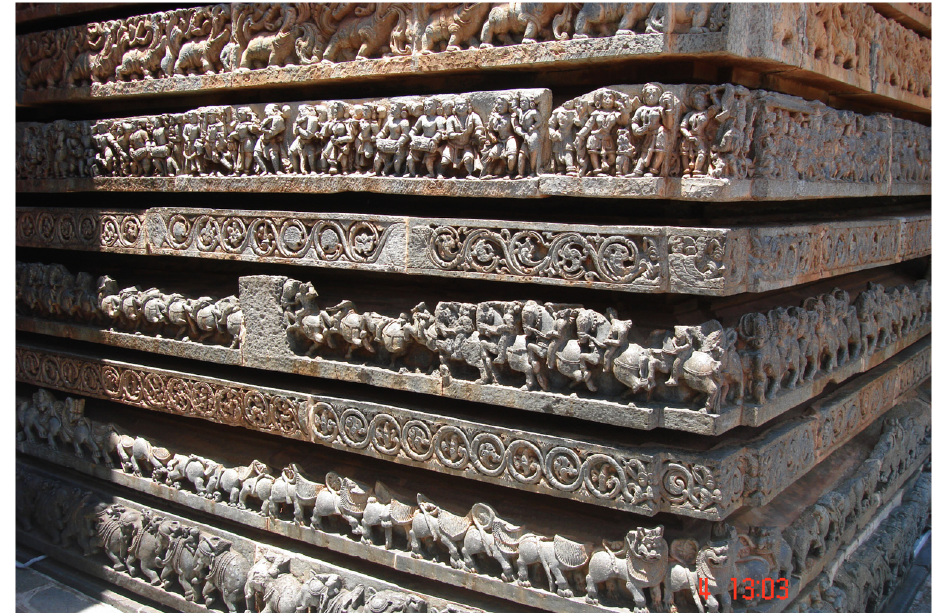
Figure 1. Religious monument in India showing an elaborate carving in soapstone, a much further evolution of an ultramaphic rock composed mainly of talc and serpentine minerals, which allows easy sculpting. Picture courtesy of J. Mudlappa.